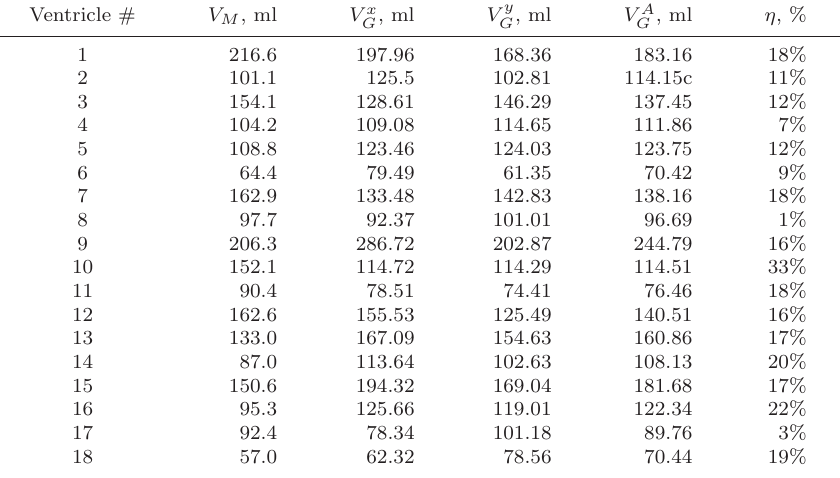
Relative error η of computed volume V A G from 2D echocardiography by using developed model and measured volume V M by using 3D echocardiography. V x G and V y G are the volumes of generated